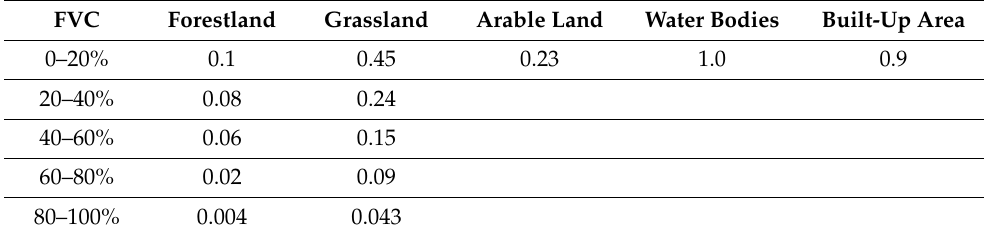
Table A1. Value for B factor under different FVC value of different land cover in Hubei province. FVC